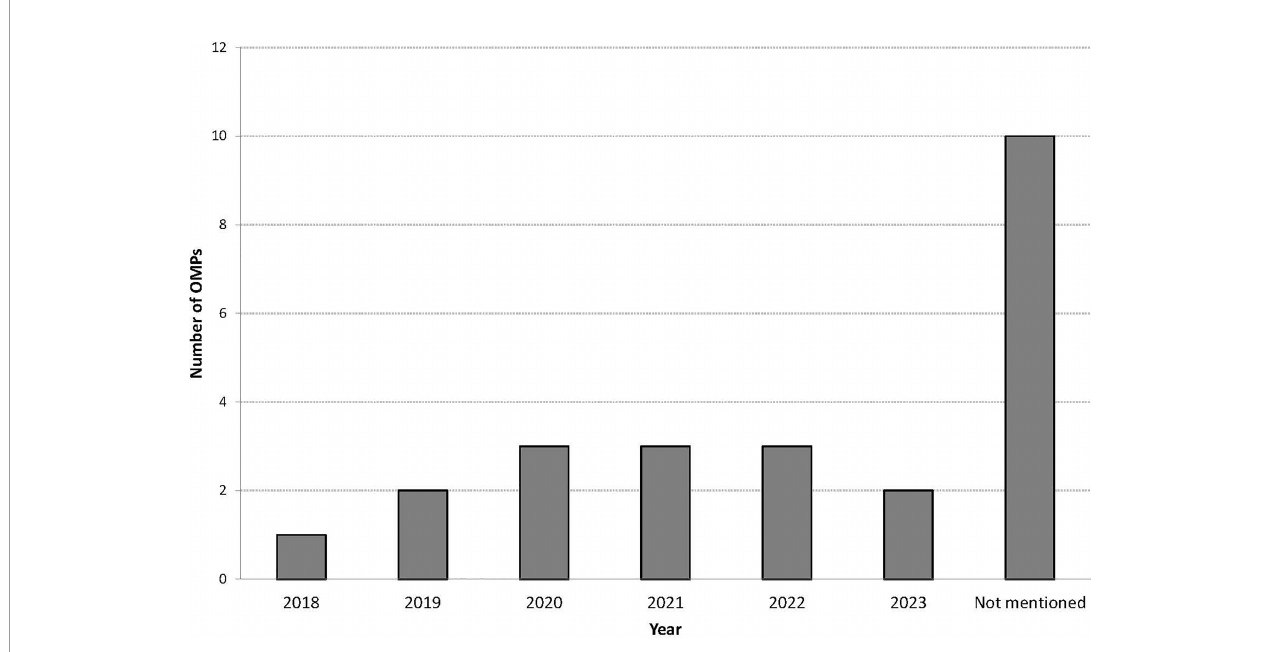
FIGURE 3 | Planned submission date for an application for MA for OMPs ongoing in